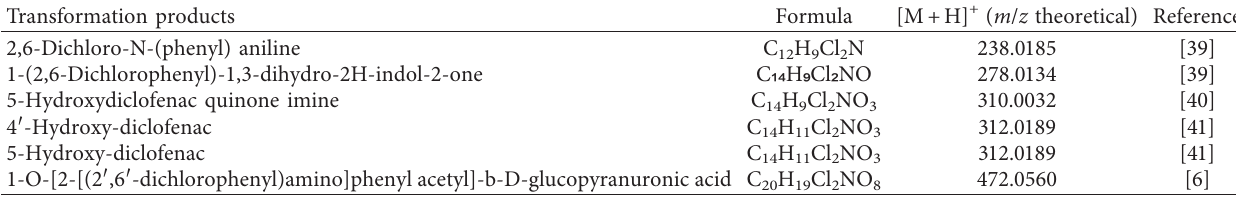
Table 1: Diclofenac transformation products reported in the literature. Transformation products